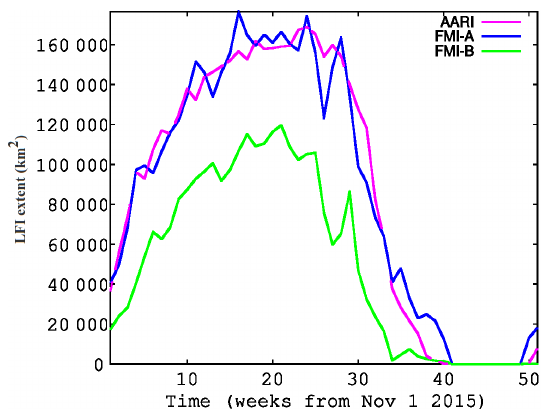
Figure 9. Ice extent time series of AARI ice charts, FMI-A and FMI-B during the 1-year period from 1 November 2015 to 31 Octo- ber 2016. The time series is weekly with FMI-A and FMI-B for the same days as the weekly AARI ice charts.